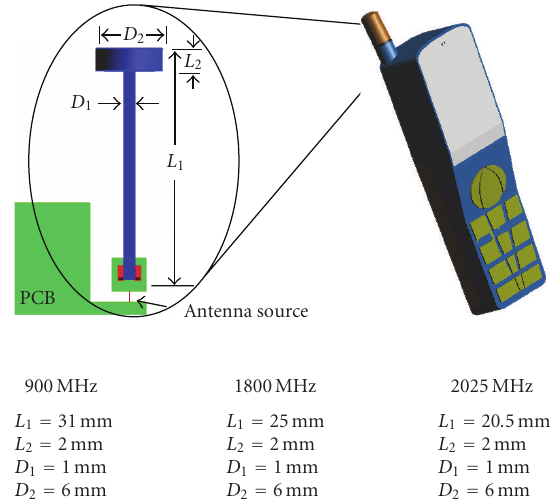
Figure 1: The SEMCAD X representation of the handset with external antenna (model-A1) showing the numerical antenna structure and its dimensions at 900, 1800, and 2025 MHz.